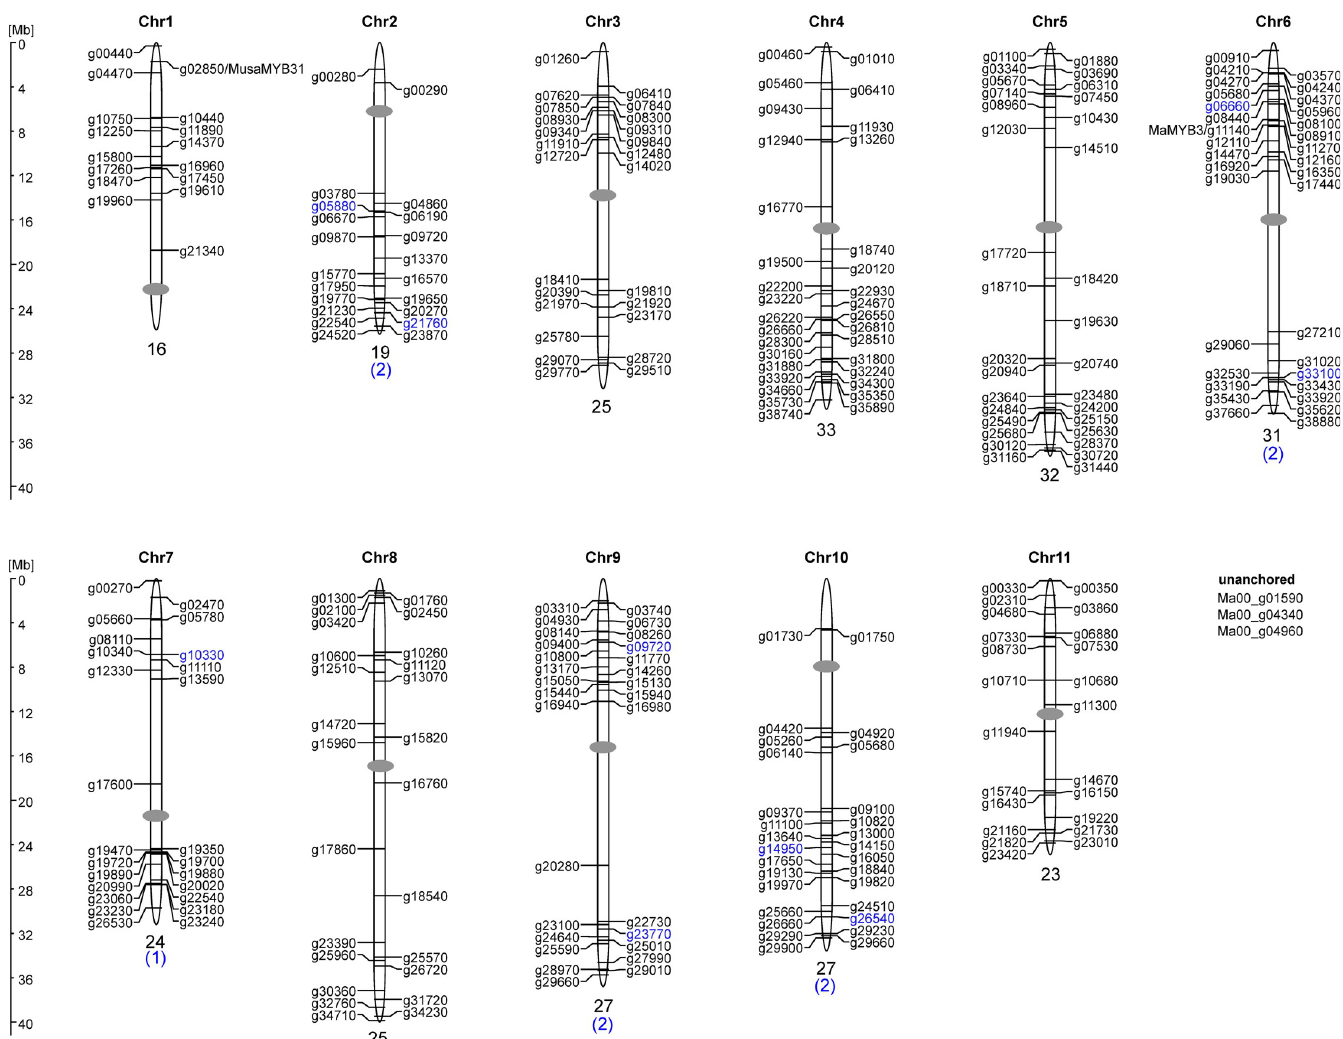
Fig 1. Distribution of MaMYB genes on the eleven M . acuminata